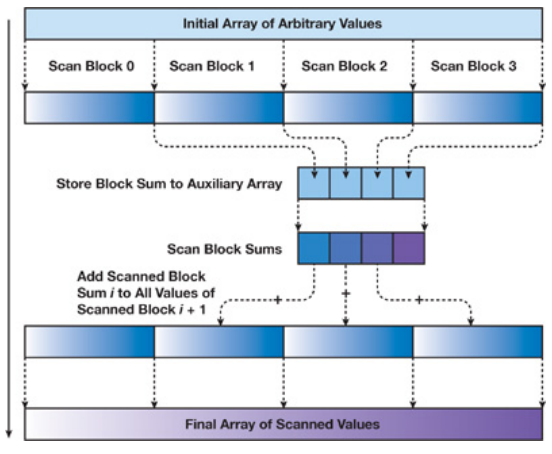
Figure 2. Illustration of segmented scan propagation (Nguyen, 2007)